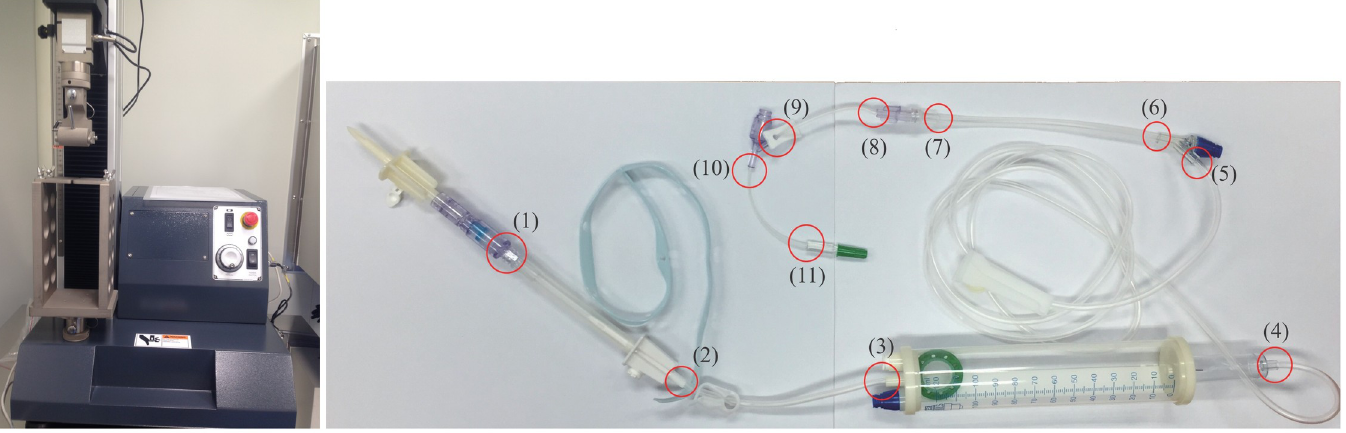
Fig 2. Detection points on administration sets for the tensile test. The red circles are the detection points.